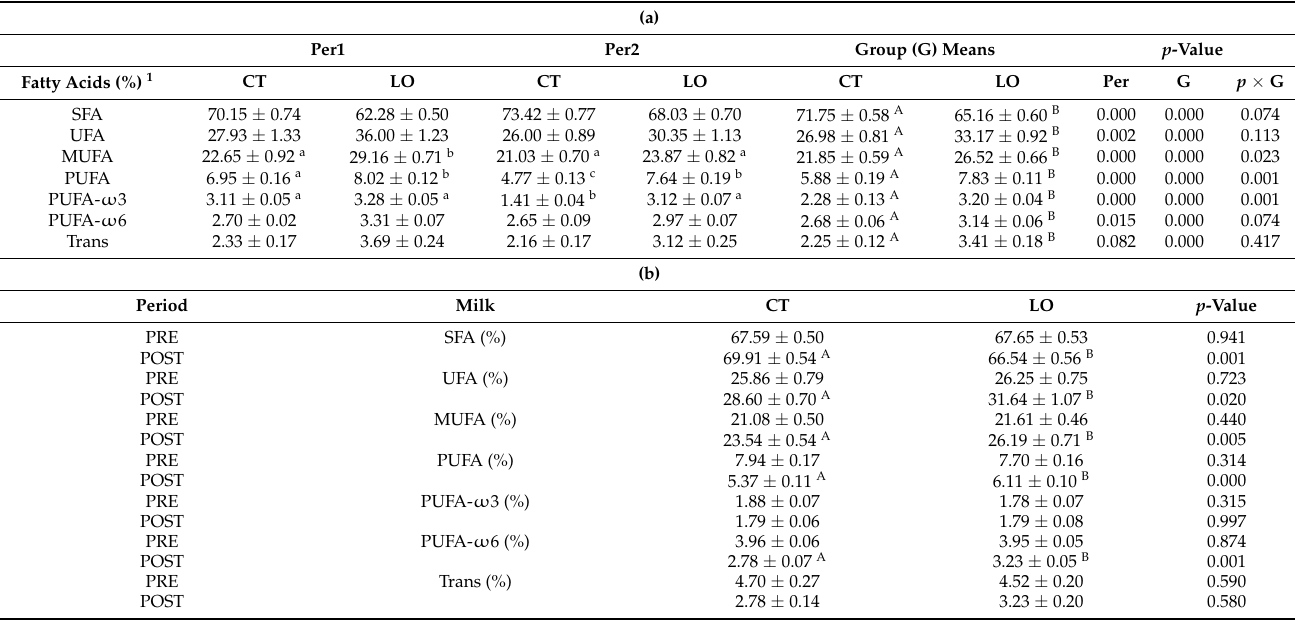
Table 4. ( a ). Milk fatty acid (FA) composition expressed on % fatty acid methyl esters (FAMEs) in Sarda dairy ewes non-supplemented (CT, n = 24) and supplemented ewes with bypass linseed oil (LO; n = 24; from Per1 to Per2). ( b ). Milk yield and milk composition in dairy Sarda ewes non-supplemented (CT; n = 24) and supplemented with bypass linseed oil (LO; n = 24) in dairy Sarda ewes non-supplemented (CT) and supplemented with bypass linseed oil (LO) before (PRE) and after (POST) the supplementation